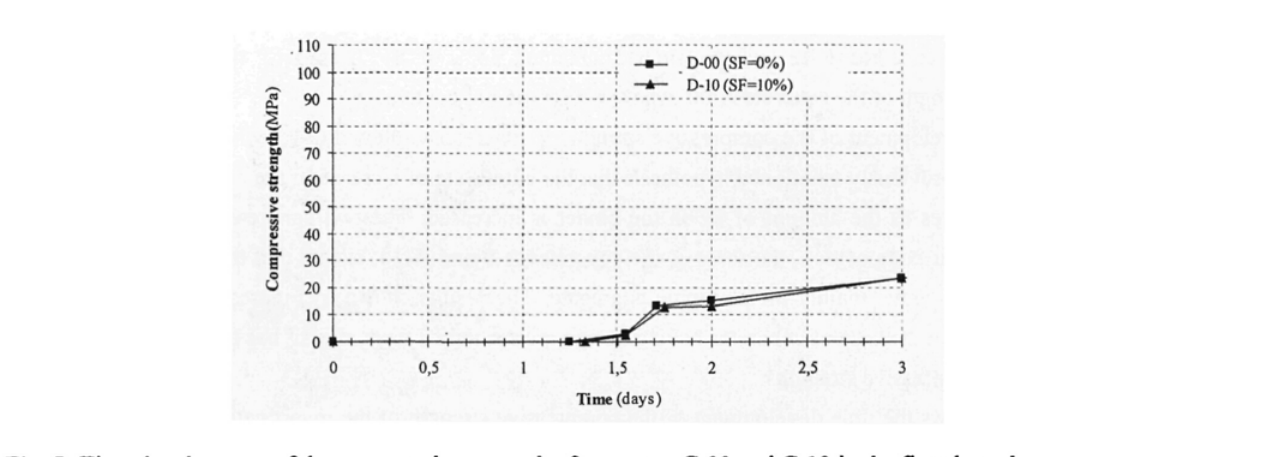
Fig. 5: Time development of the compressive strength of concretes C-00 and C-10 in the first three days.